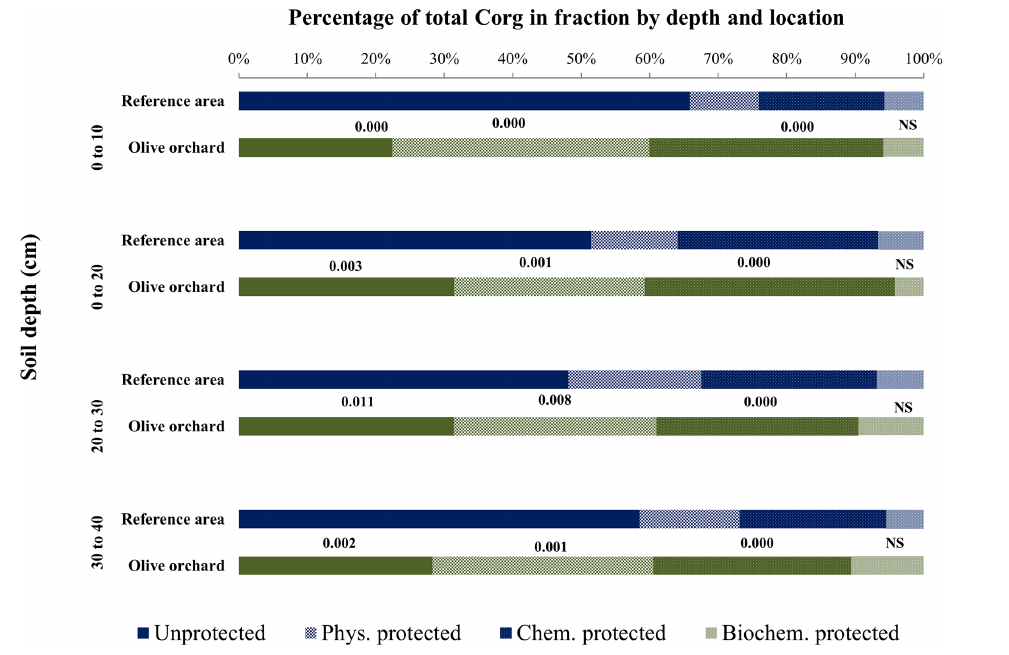
Figure 5. Contribution (%) of the different fractions with respect to total soil organic carbon by depth, comparing the reference site vs. the olive orchard. The labels of each fraction and depth are the p value according to a one-way ANOVA comparing the reference area vs. the olive orchard for the same carbon fraction and soil depth.